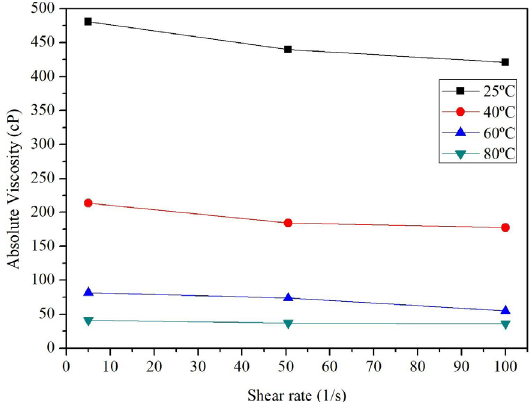
Figure 3. Influence of temperature on OSE rheology.